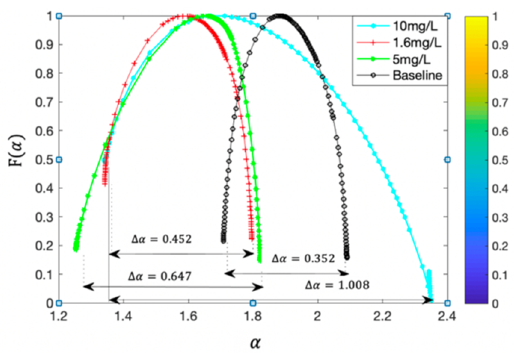
Figure 2. Multi-fractal singular spectra of Ammonia Nitrogen for different concentrations of Copper Sulfate.